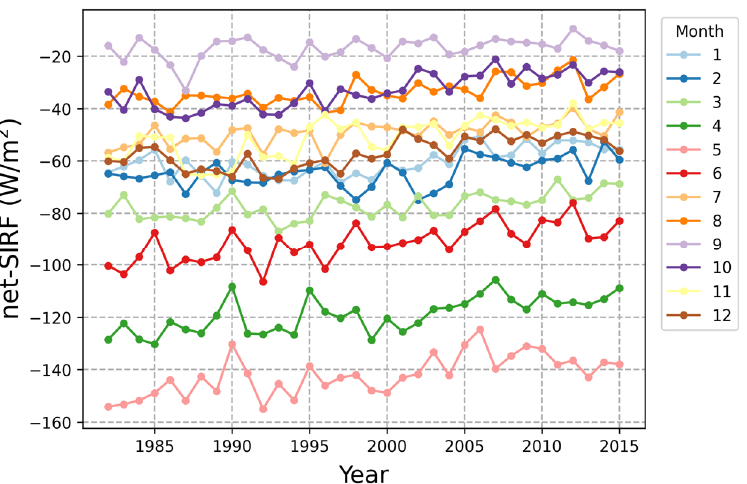
Figure 7. Temporal distribution of the monthly net-SIRF using the average of five radiative kernels.